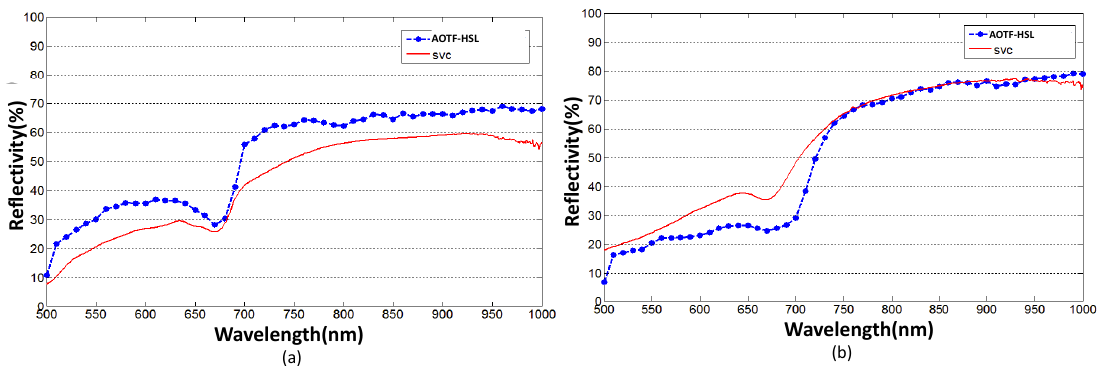
Figure 9. HSL derived spectral profile of yellow leaves from ( a ) dracaena, ( b ) aloe compared with spectrometer measurements .